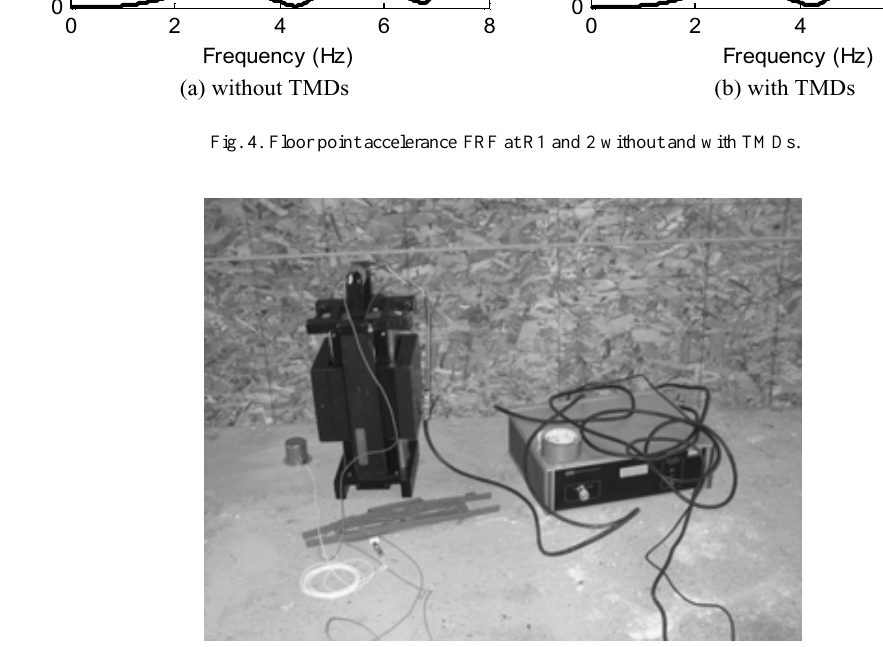
Fig. 5. Shaker, amplifier and accelerometers used for the modal testing.